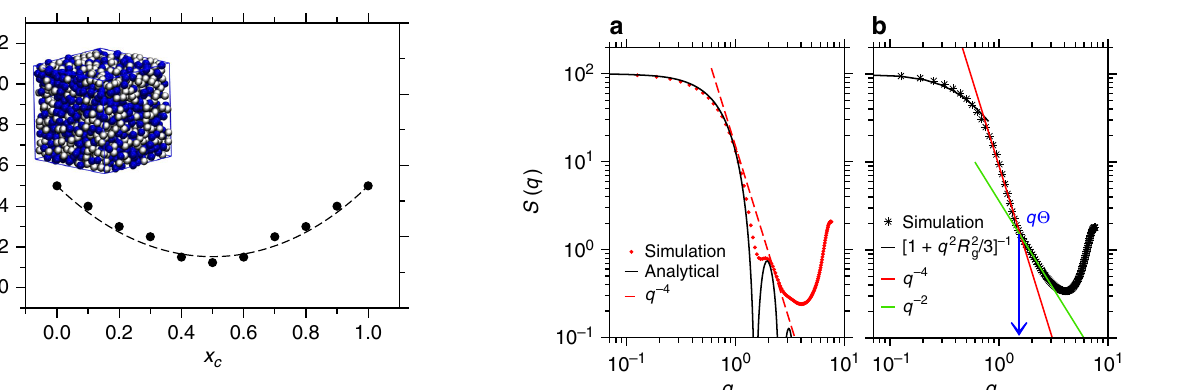
Fig. 2 Dependence of bulk solution number density with different solvent – cosolvent mixing ratios. Main panel presents ρ total for the generic model as a function of cosolvent mole fraction x c . The line is drawn based on Eq. (3), with ρ total = 1/ v . In the inset, we show a simulation snapshot of the generic system presenting bulk solution for a x c = 0.5 mixture. The generic parameters for the bulk solution are chosen such that the density dip observed in generic model closely resembles aqueous methanol mixture, see Supplementary Fig. 1